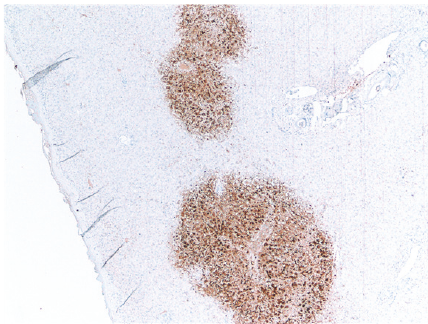
Figure 5: Case #3 trend in AST and ALT. ALT: alanine aminotrans- ferase; AST: aspartate aminotransferase.